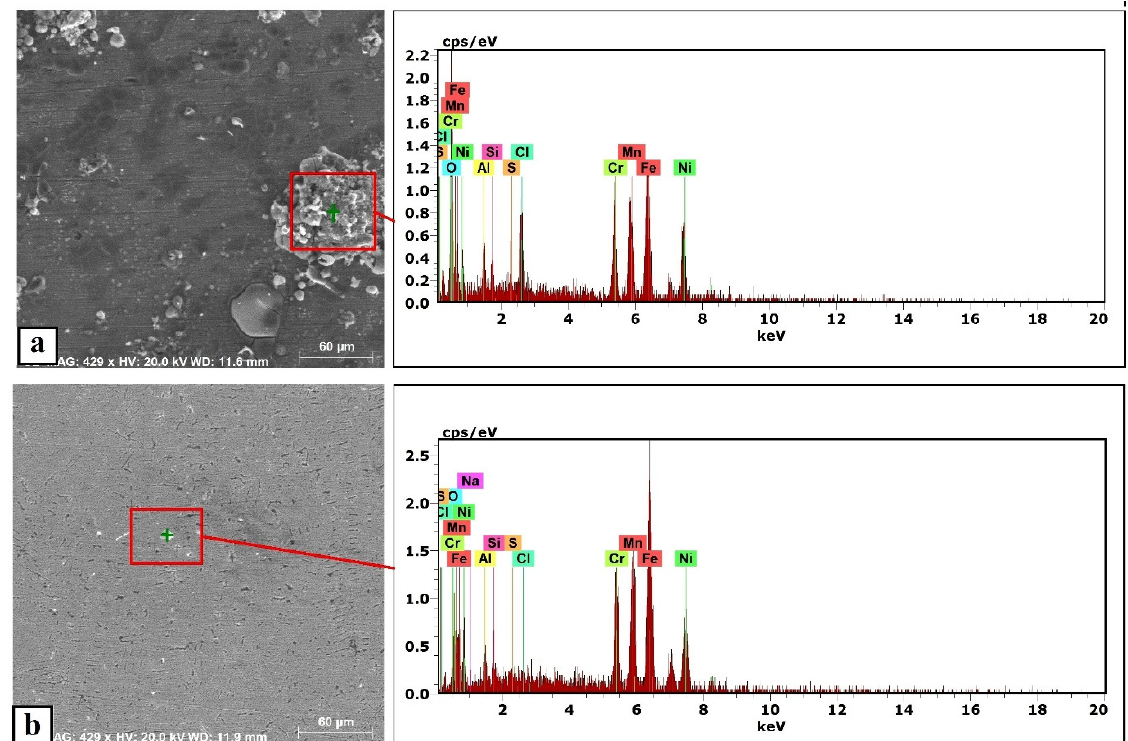
Figure 13. EDX patterns of the corroded HEA in ( a ) cold-rolled and ( b ) solution-treated condition in 0.6 M NaCl + 0.5 M H 2 SO 4 solution.